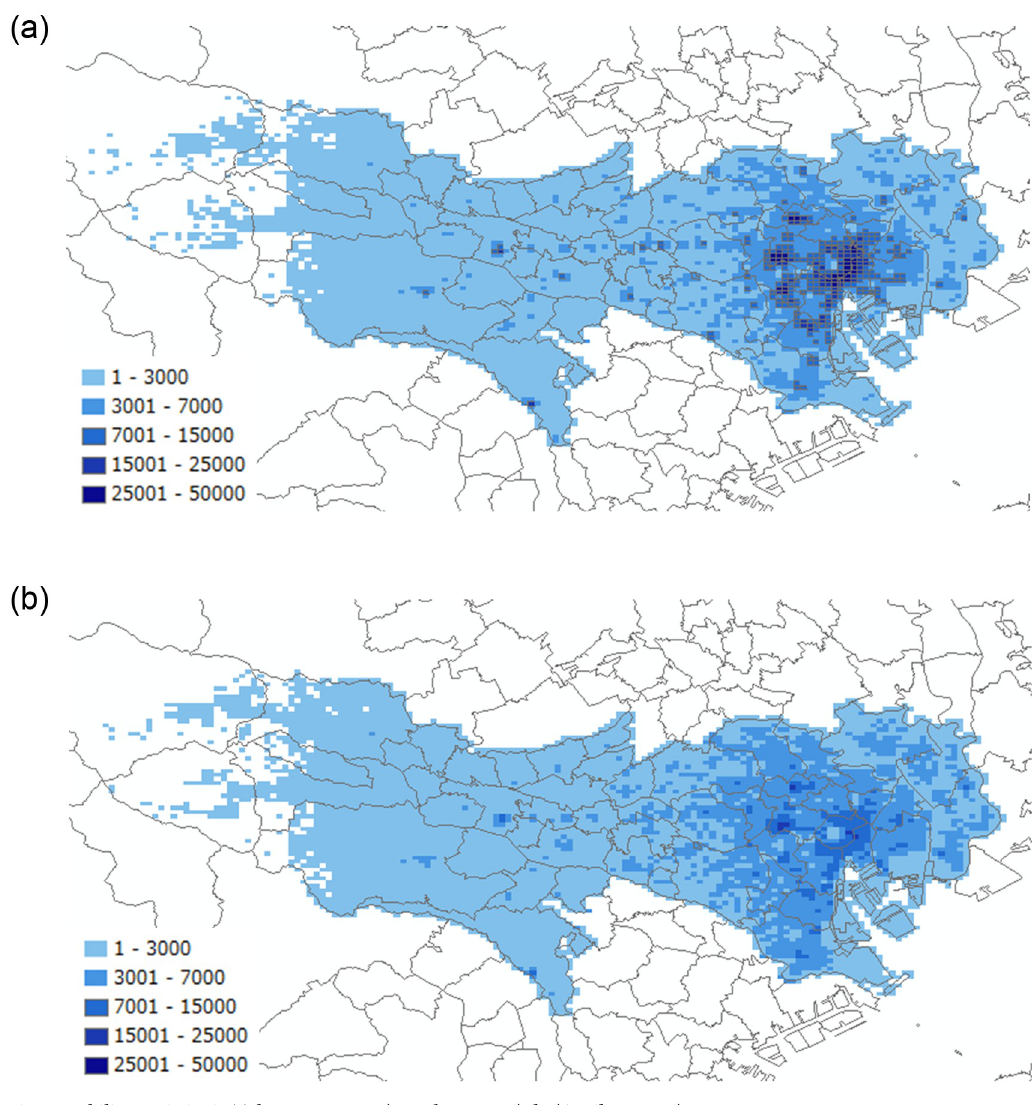
Fig 2. Mobility statistics in Tokyo at 15:00: a. (March 13, 2020), b. (April 23, 2020).